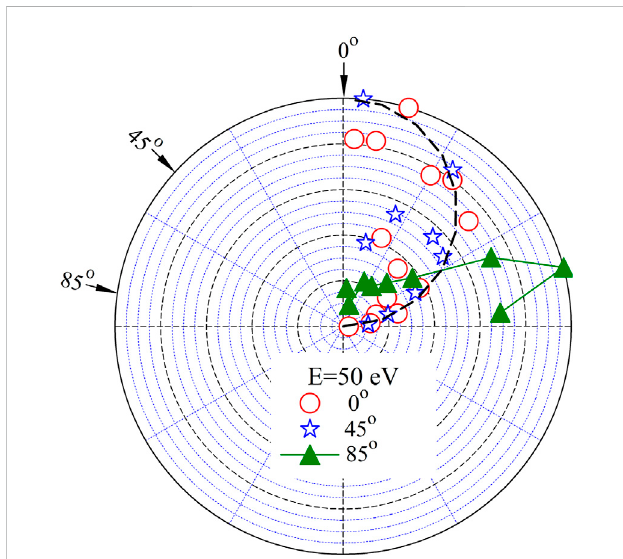
FIGURE 10 Angular distributions of re fl ected H atoms for incident H at an impactenergyof50 eV,fromana:LiHsurfaceat300 Kforvariousangles of incidence. The distributions are shown in the form of a polar diagram with the re fl ected particle curves normalized to unity at their maximum values for each angle of incidence. Lambert ’ s cosine law is shown by a dashed line.